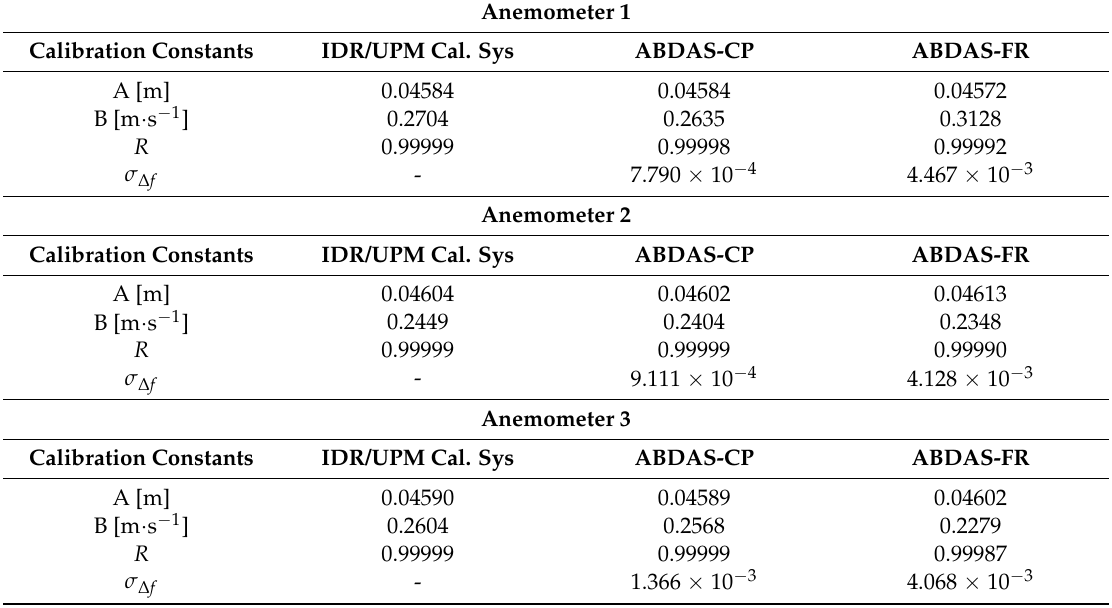
Table 5. Calibration coefficients, A, B, and correlation coefficient R , (see Equation (5)) resulting from the calibrations performed to Anemometers 1–3. The coefficients included in the table are the ones obtained from the IDR/UPM accredited calibration process, and the ones from the data measured with ABDAS and post-processed counting pulses (ABDAS-CP; see Equation (6)) and using the Fourier transform (ABDAS-FR; see Equation